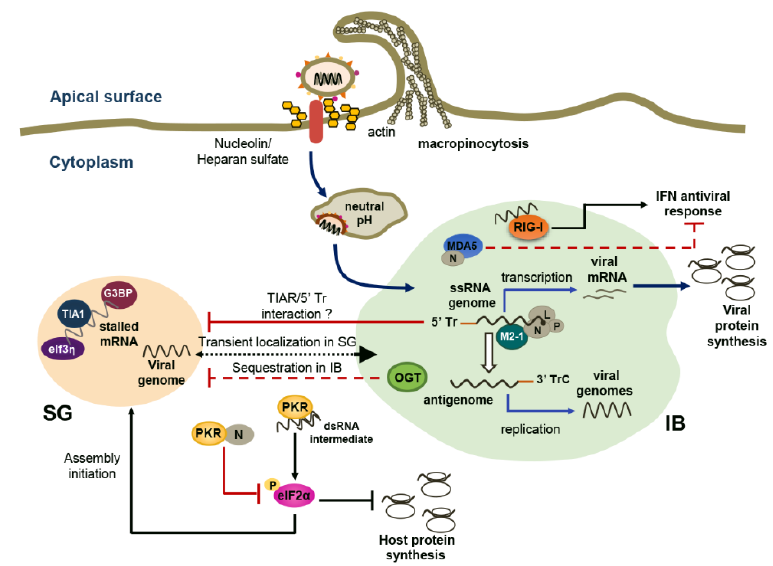
Figure 2. Crosstalk between SGs and IBs during RSV infection. Respiratory syncytial Virus (RSV) infection triggers the formation of cytoplasmic G3BP1/TIA1/eIf3 η positive stress granules (SGs) and inclusion bodies (IBs). Viral genomic ssRNA transiently localizes within SGs, but is mainly associated in IBs. Colocalization of RSV ribonucleoprotein complex, composed of N, P and L, and of the M2-1 protein in IBs suggests that IBs favor RSV replication and transcription. IBs also contain the pattern recognition receptors, retinoic acid-inducible gene I (RIG-I) and melanoma differentiation-associated protein 5 (MDA5), which sense viral replication intermediates to trigger the interferon (IFN) antiviral response. Interaction of N with MDA5 is thought to counteract the antiviral response. Formation of SGs containing stalled mRNA to inhibit their translation is initiated upon activation of dsRNA-dependent protein kinase R (PKR) by dsRNA intermediates and downstream eIF2 α phosphorylation. However, several mechanisms limit the formation of SGs. First, PKR-dependent eIF2 α phosphorylation is limited by the interaction of RSV N with PKR. Second, the 5’ extragenic trailer sequence (5’ Tr) of the RSV genome interferes with SG assembly possibly through interaction with TIA1-related (TIAR) protein, as it was shown during SeV infection. Finally, RSV induces the redistribution of the O-linked N -acetylglucosamine transferase (OGT), an enzyme critical for assembly of stalled RNA into SGs, into IBs.